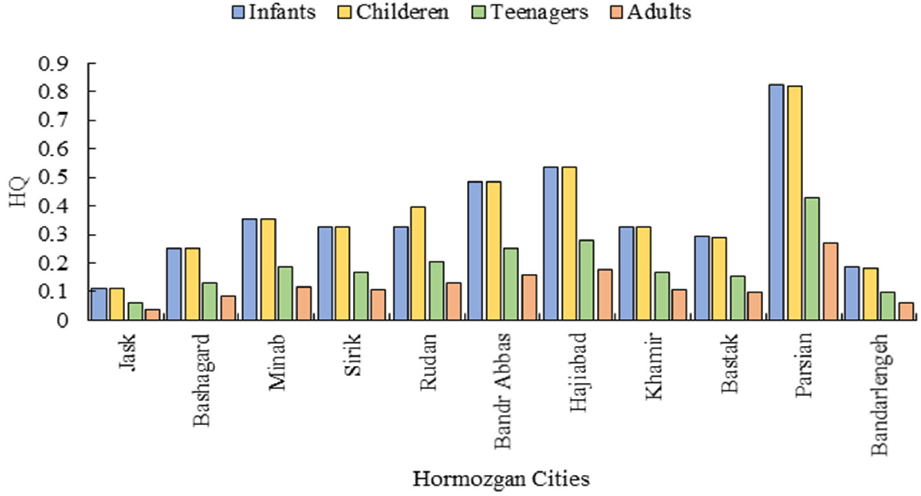
Figure 6. HQ Values for exposure to nitrate in cities of Hormozgan province in different age groups.